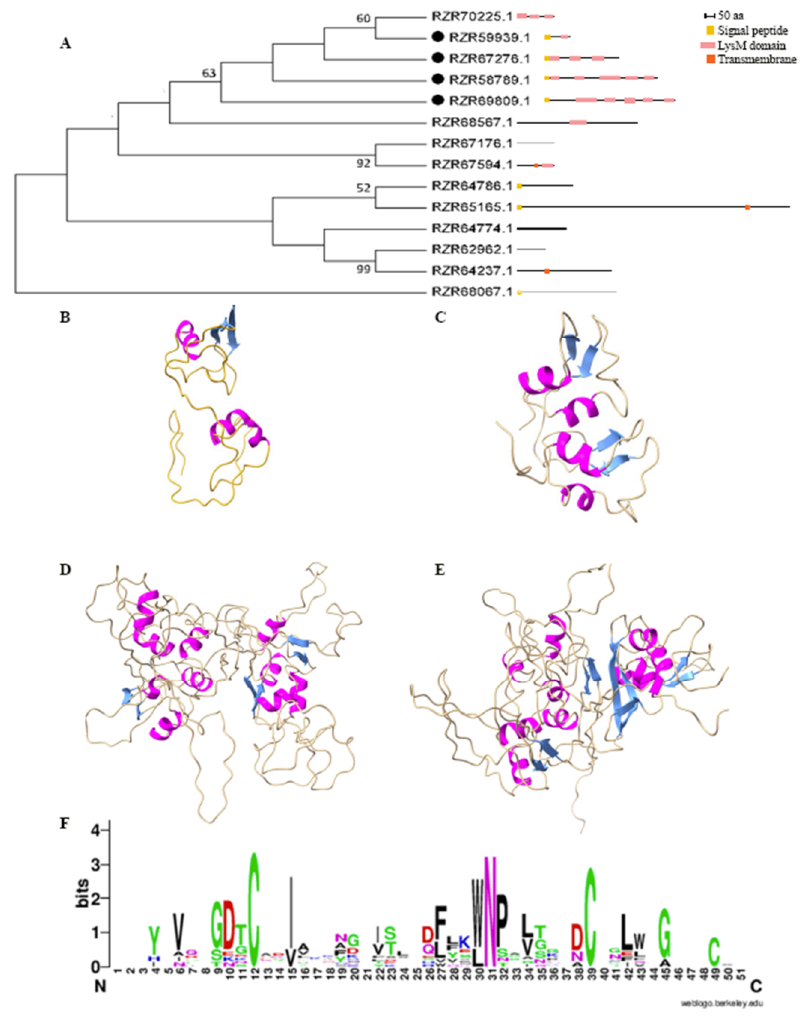
Figure 1. Putative LysM effectors of the nematophagous fungus Pc123. ( A ) Phylogeny of the 14 Pc123 proteins containing LysM domains. Dots indicate putative LysM effectors. ( B – E ) Molecular modelling Pc123 putative LysM effectors: ( B ) Pc123Lys1; ( C ) Pc123Lys2; ( D ) Pc123Lys3; ( E ) Pc123Lys4. ( F ) We- bLogo analysis of domains of Pc123 putative LysM effectors. Phylogenetic analysis was performed in MEGA X v10.1 by aligning the sequences using ClustalW v2.0.12, with a Maximum Likelihood,